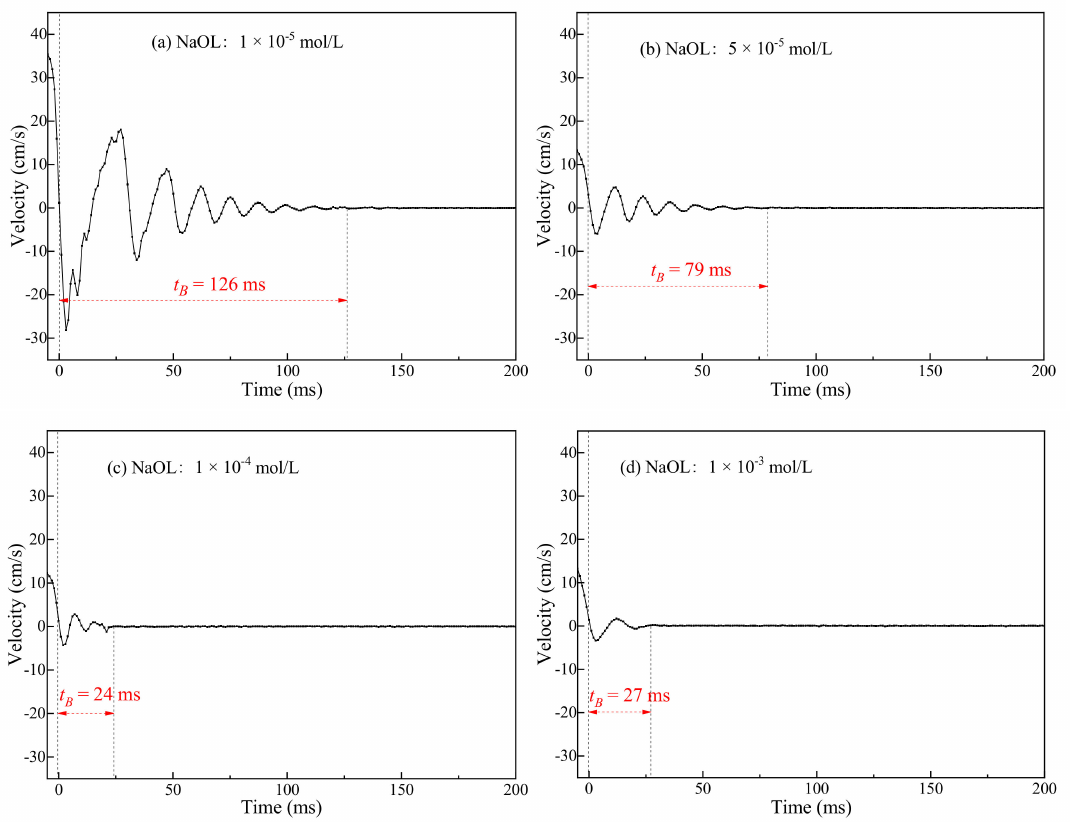
Figure 9. Bubble velocity variation during the collision-rebound process with the muscovite surface in the NaOL solution with different concentrations. ( a ) 1 × 10 − 5 mol/L; ( b ) 5 × 10 − 5